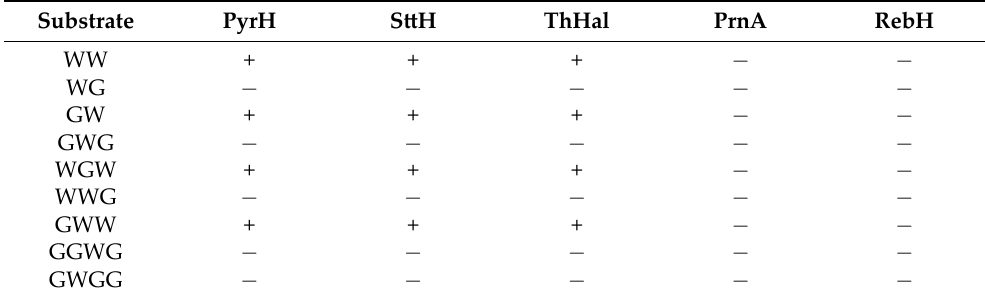
Table 1. Chlorination of short peptides using five wild type halogenase